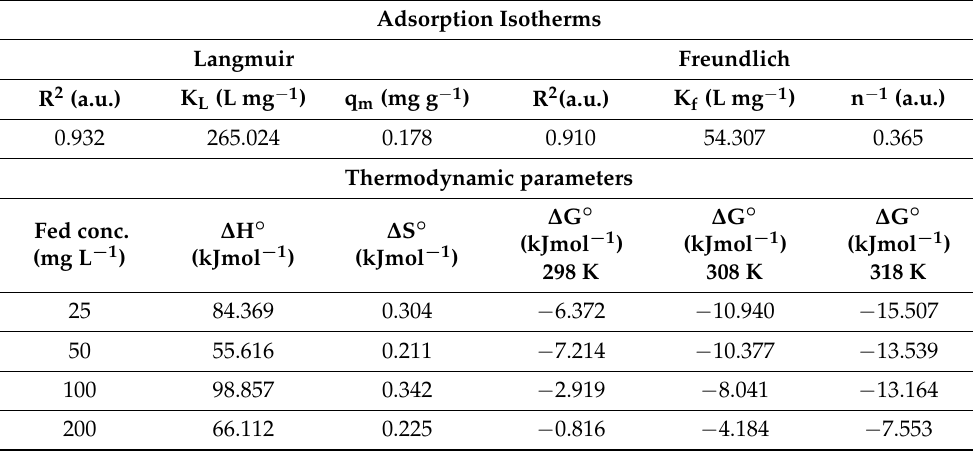
Table 2. Isotherms and thermodynamic parameters for IGC adsorption onto the Al 2 O 3 -NiO Table 2. IsothermsandthermodynamicparametersforIGCadsorptionontotheAl 2 O 3 -NiO nanocomposite. nanocomposite. Adsorption Isotherms Adsorption Isotherms Langmuir Freundlich